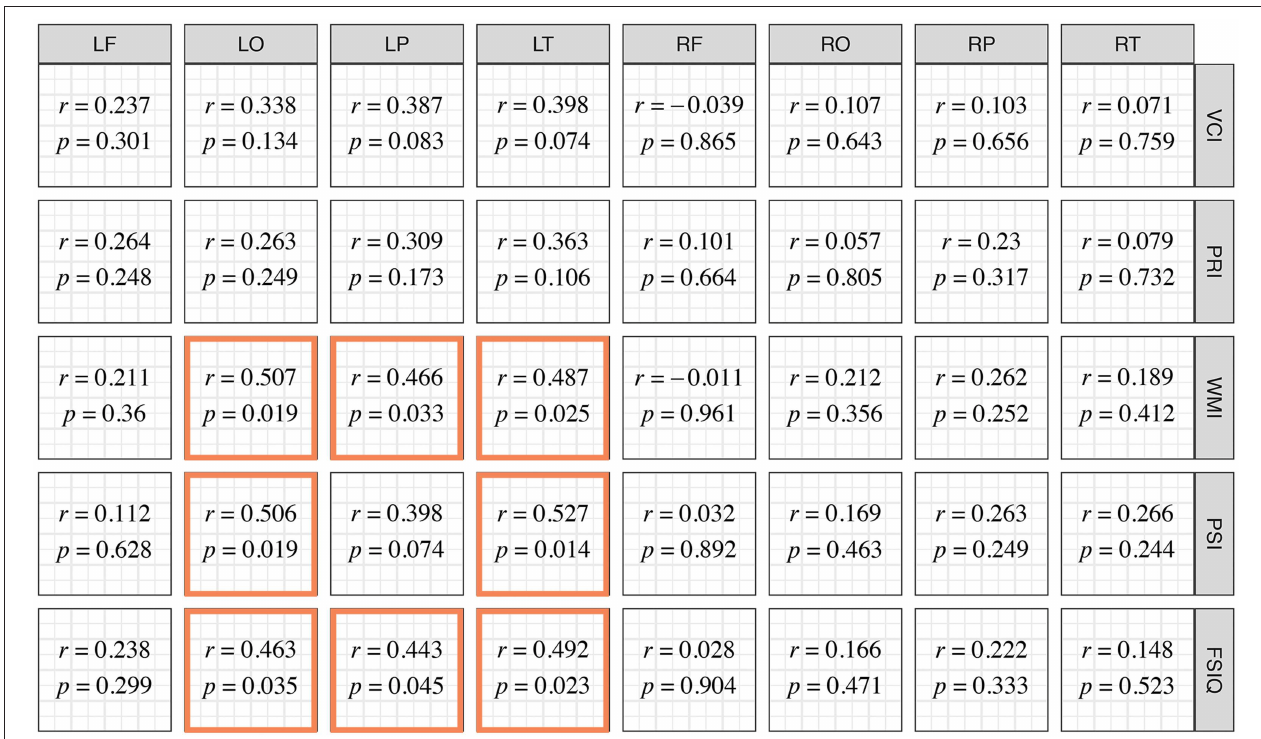
FIGURE 5 | Correlation Coefficient between Lobular Relative Cerebral Blood Flow and Index Scores of WISC-IV. Correlations with statistical significance are emphasized with colored frames.